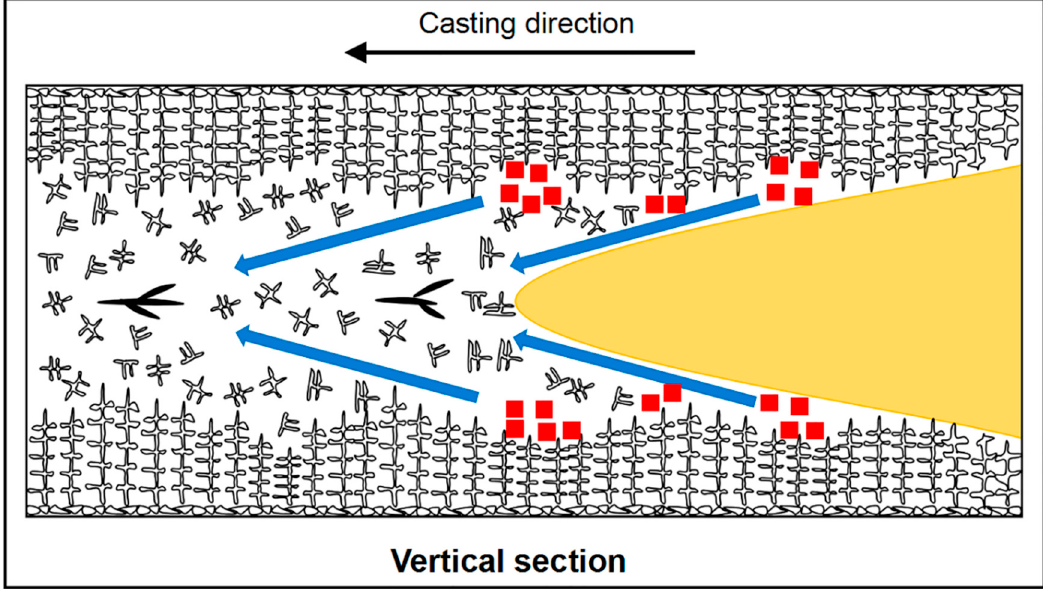
Figure 14. The formation mechanism of central segregation in cold heading steel billet, in which the red square symbols represent the segregated solute during the solidification and blue arrows represent the main flow of segregated solute driven by solidification shrinkage.